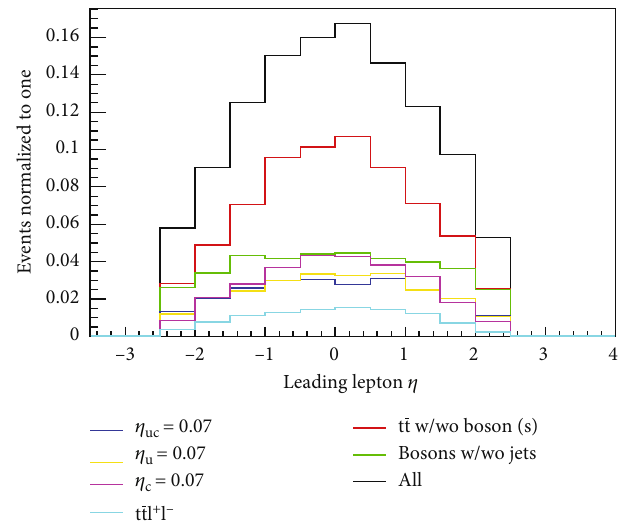
Figure 9: Lepton η distributions for signal and backgrounds: general detection is